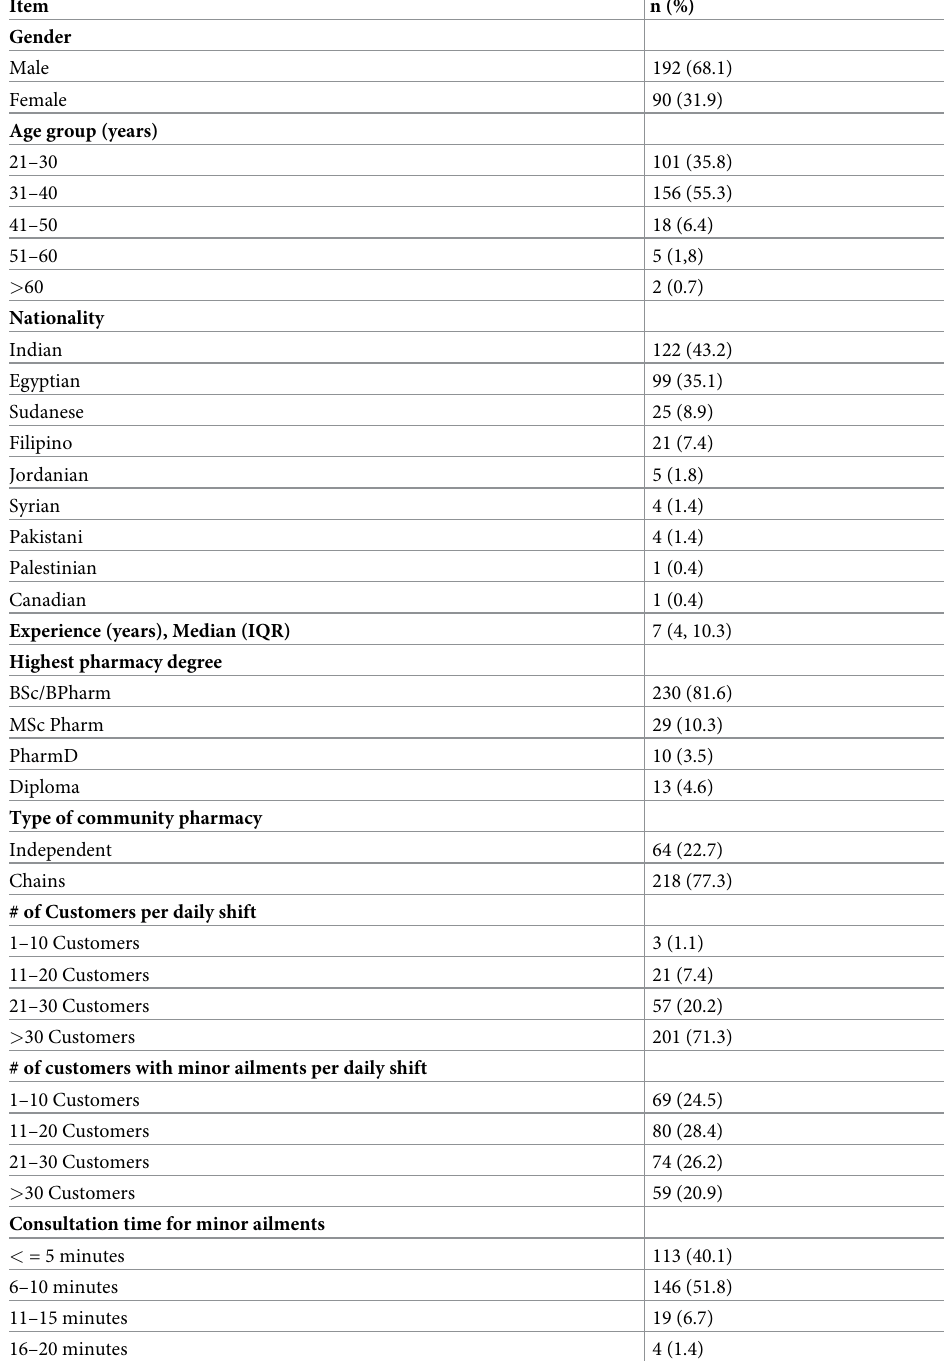
Table 1. Community pharmacists’ demographic and workload data related to minor ailments in Qatar (N =